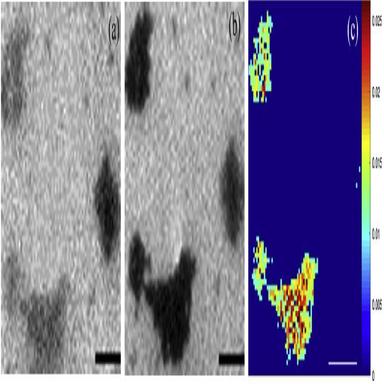
Soft X-ray STXM images for the CNF/Fe3O4/TiO2 nanopaper. (a) STXM image of the nanopaper at the energy of 700 eV before the absorption edge. (b) STXM image of the same sample at the absorption edge energy of 708 eV. (C) Dual-energy contrast imaging of Fe3O4 inside based on STXM contrast calculation. The scale bar is 2 μm.